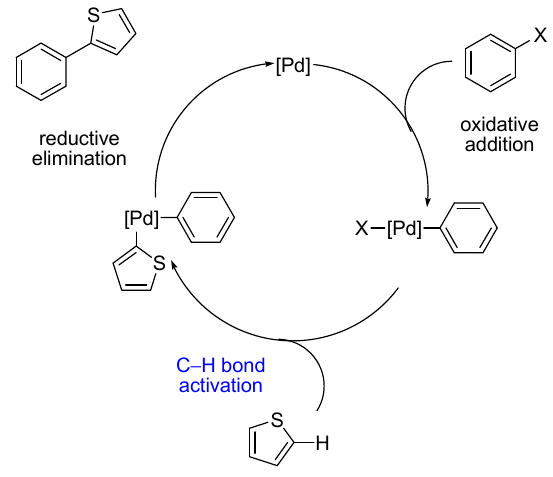
Figure 2. Catalytic cycle for Pd-catalyzed direct hetero arylation (DHA) reaction and possible transition states for C–H bond activation.